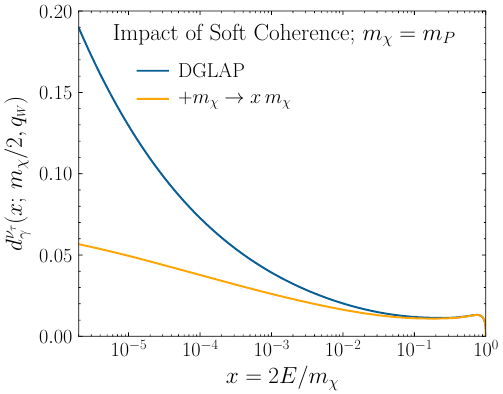
Figure 6 . An example of the impact of the m χ → x m χ substitution on our high scale FFs. This particular example shows the evolution of a Planck scale γ to an electroweak scale ν without the